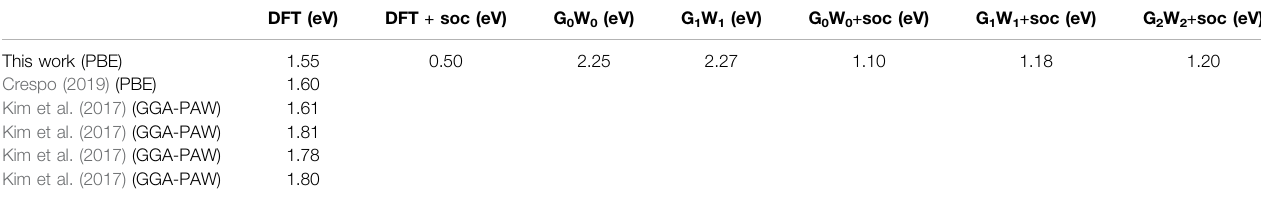
TABLE 2 | DFT and self-consistent GW bandgaps of pseudo-cubic CH 3 NH 2 CH 3 PbI 3